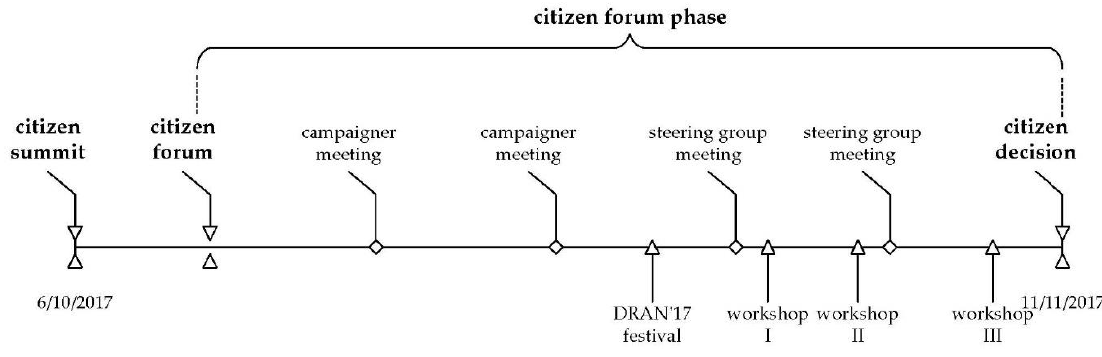
Figure 4. Formal structure of the participation process.